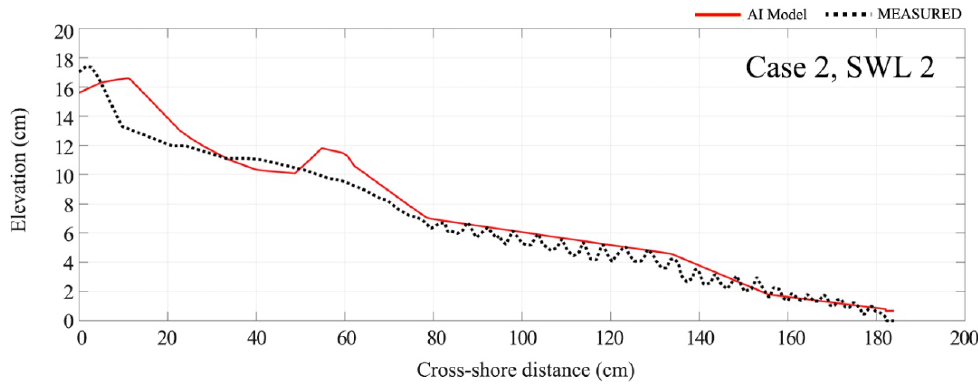
Figure 17. Case 2 SWL 2 comparison of the ANN prediction and measured from the physical test.